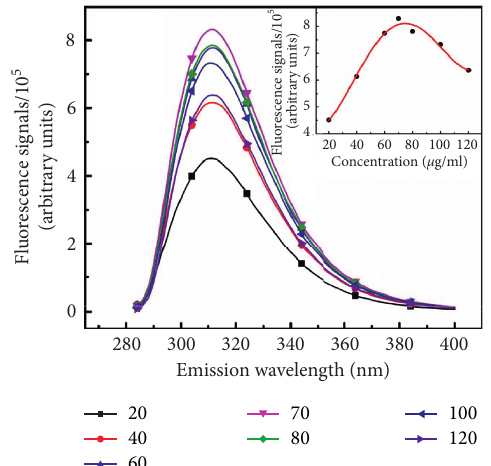
Figure 3: Fluorescence emission spectra of aqueous solution of different concentrations of catechin. The concentration of catechin is from 20 to 120 μ g/mL, and the corresponding inset is the fluorescence peak of catechin aqueous solution as a function of concentration.